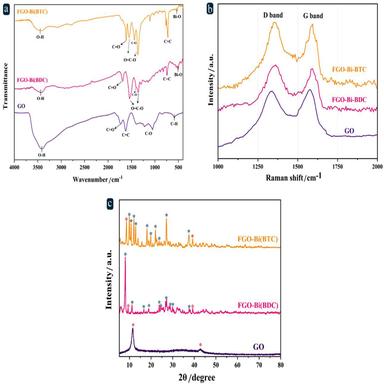
a) FT-IR spectra, b) Raman, and c) XRD pattern of GO, FGO-Bi(BTC), and FGO-Bi(BDC).